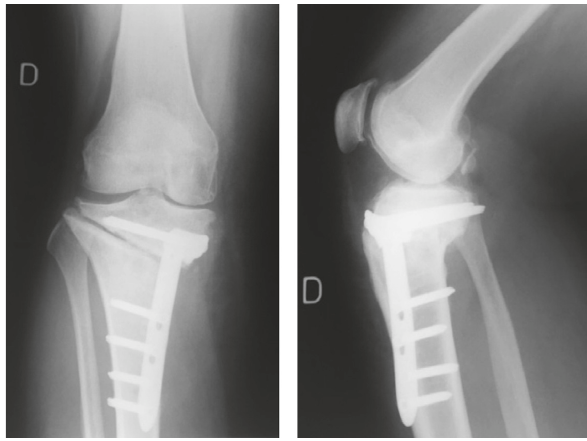
Figure 6: June 2011, 1-year after revision, postoperative X-rays showing fracture of the plate and translation of the proximal fragment of the HTO.